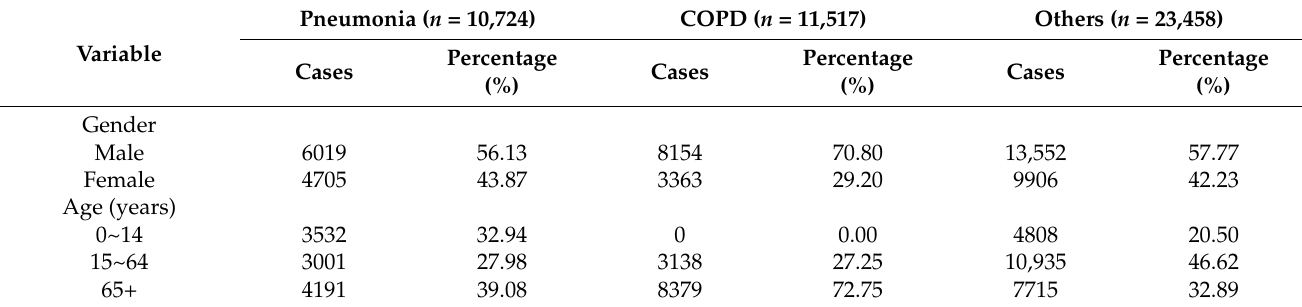
Table 3. Gender and age distribution of inpatients with respiratory